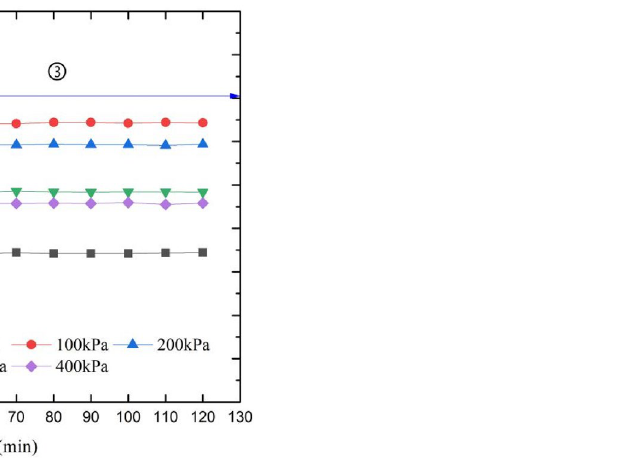
Figure 7. Cumulative collapsibility of sample